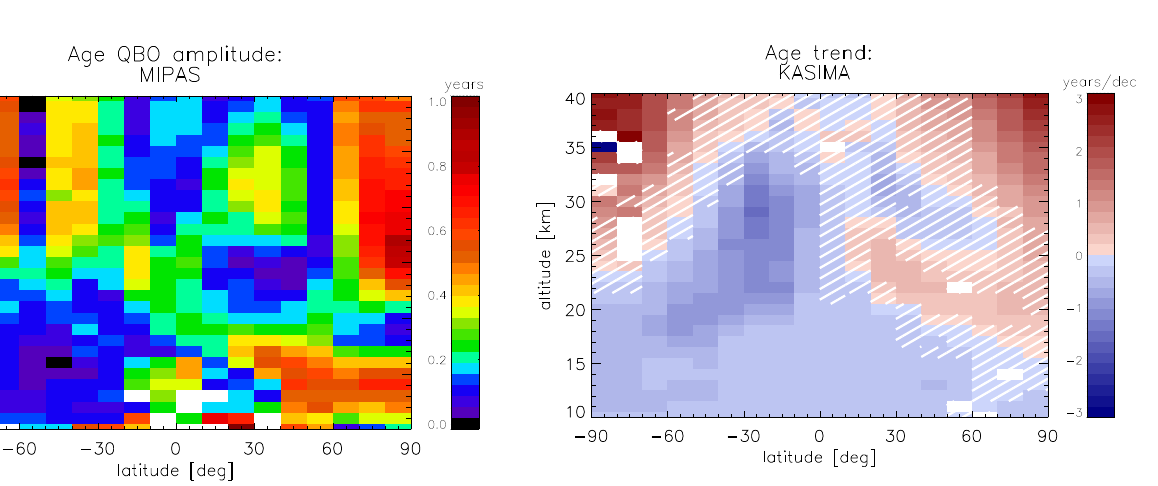
Figure 9. Altitude–latitude cross-sections of amplitudes of the QBO variation of mean age of air.